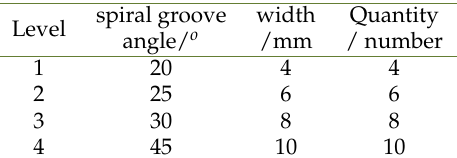
Fig. 12. Flow field analysis diagram of tangential hole plunger. Table 3. Orthogonal experiment factor level table of spiral